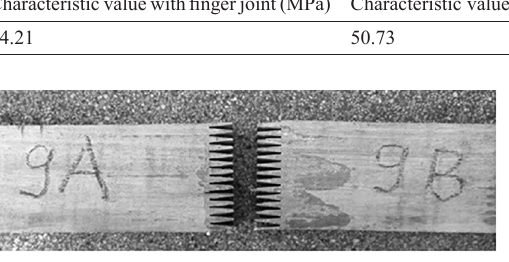
Figure 4: Specimen with finger joint before gluing.